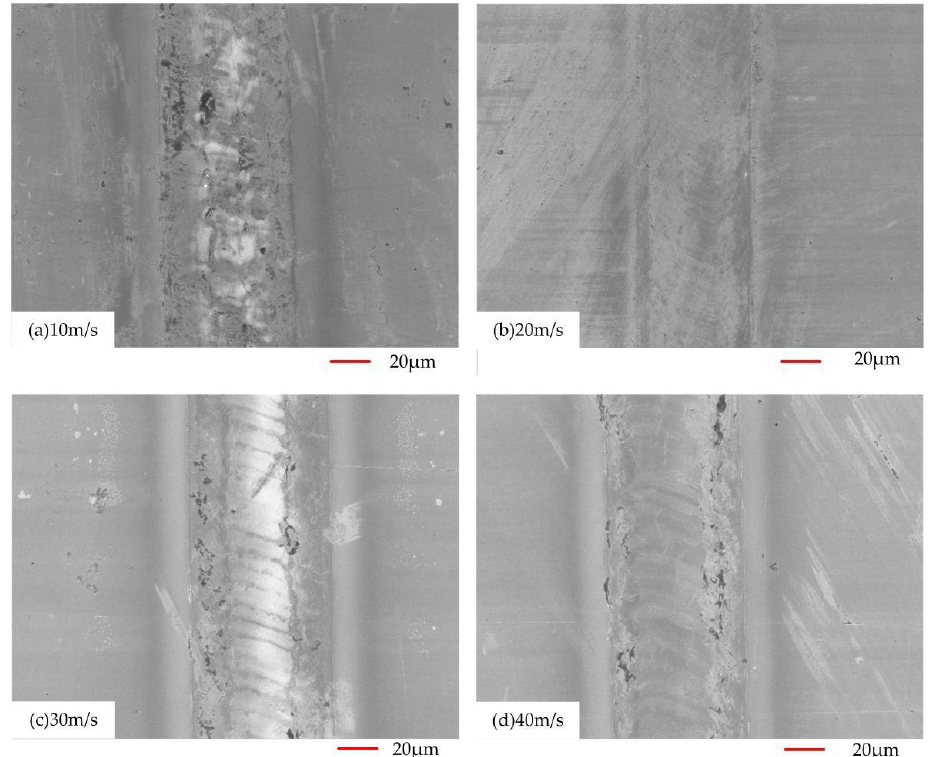
Figure 7. Micromorphology of the remelted layer at different scanning speeds, ( a ) 10 m/s; ( b ) 20 m/s; ( c ) 30 m/s; ( d ) 40 m/s. ( c ) 30 m/s; ( d ) 40